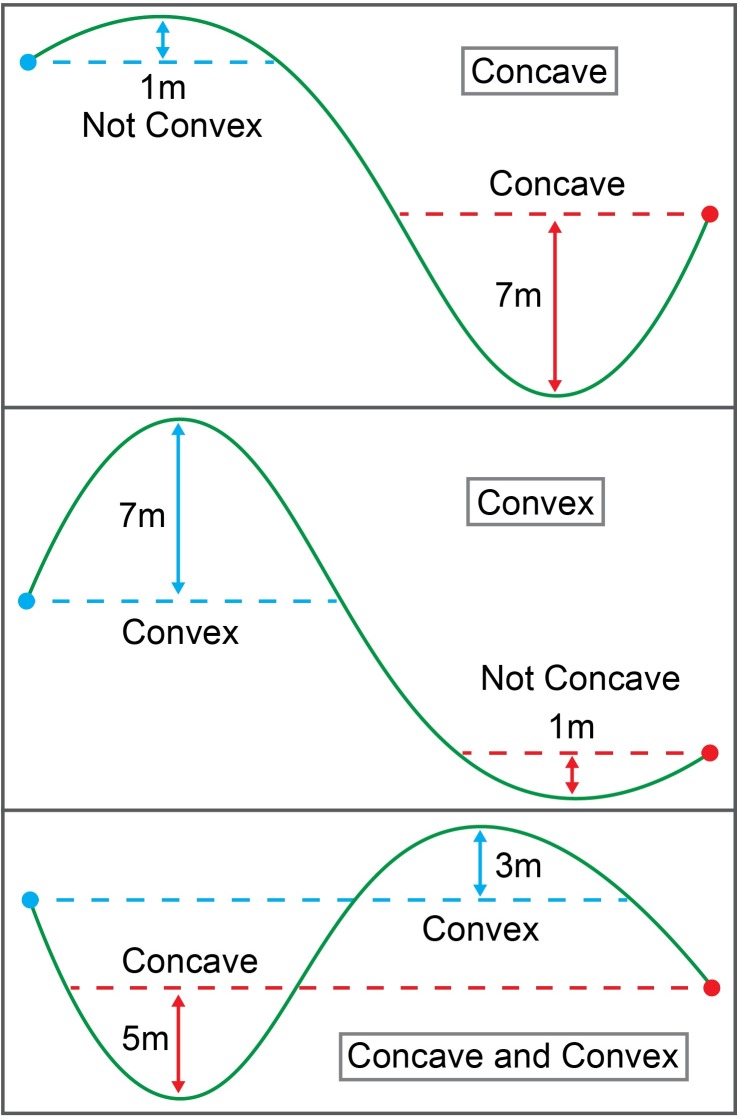
Illustration of slope classification as concave, convex, or both.Blue dots represent the higher of the two LOS endpoints while red dots represent the lower of the two LOS endpoints. Green lines represent the ground surface along the LOS path.